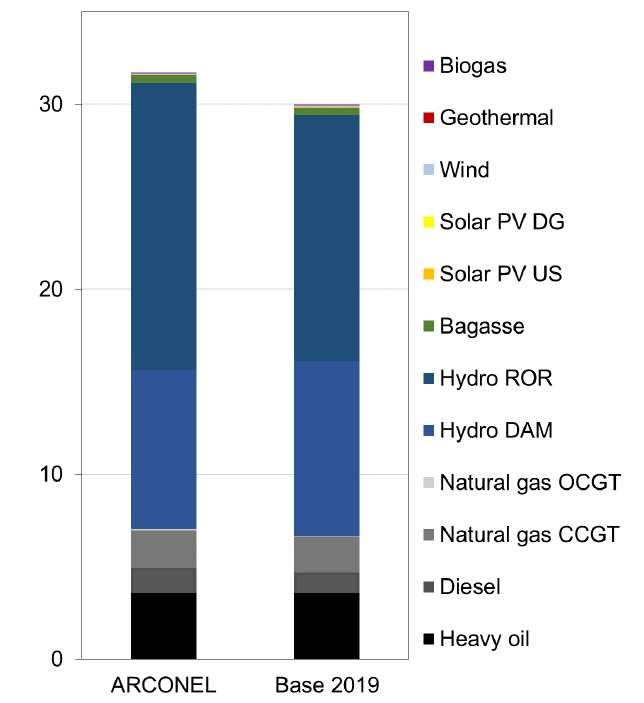
Figure 8. Annual electricity generation in TWh according to the urbs model Base 2019 and the ARCONEL statistics of